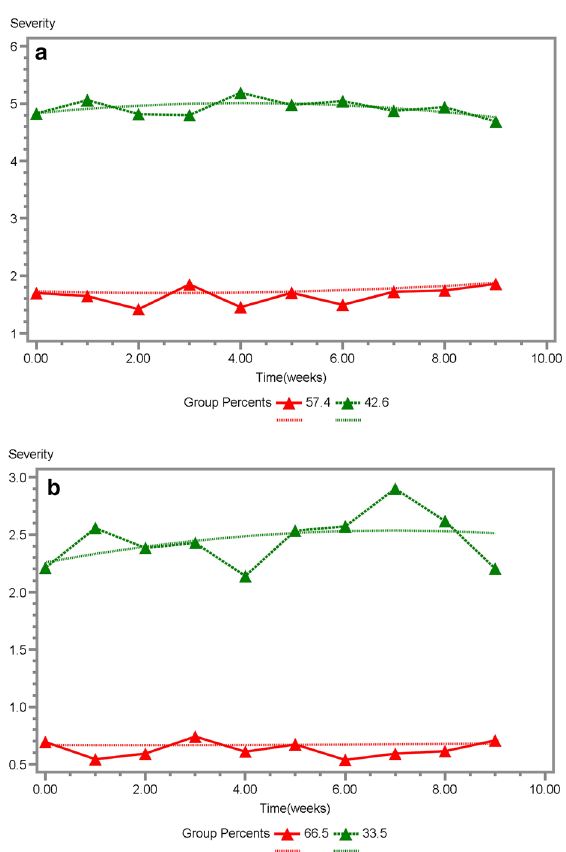
Figure 3. ( a ) Group-based trajectory modeling of the top 5 symptoms. ( b ) Group-based trajectory modeling of the immunotherapy specific